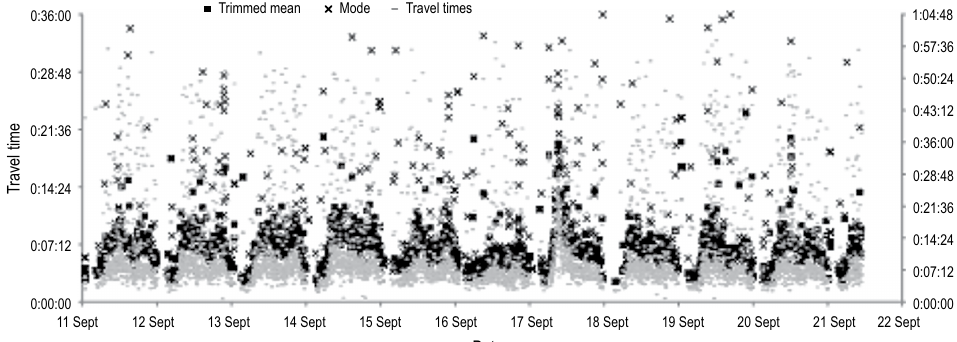
Fig. 9. Scatter plot of travel